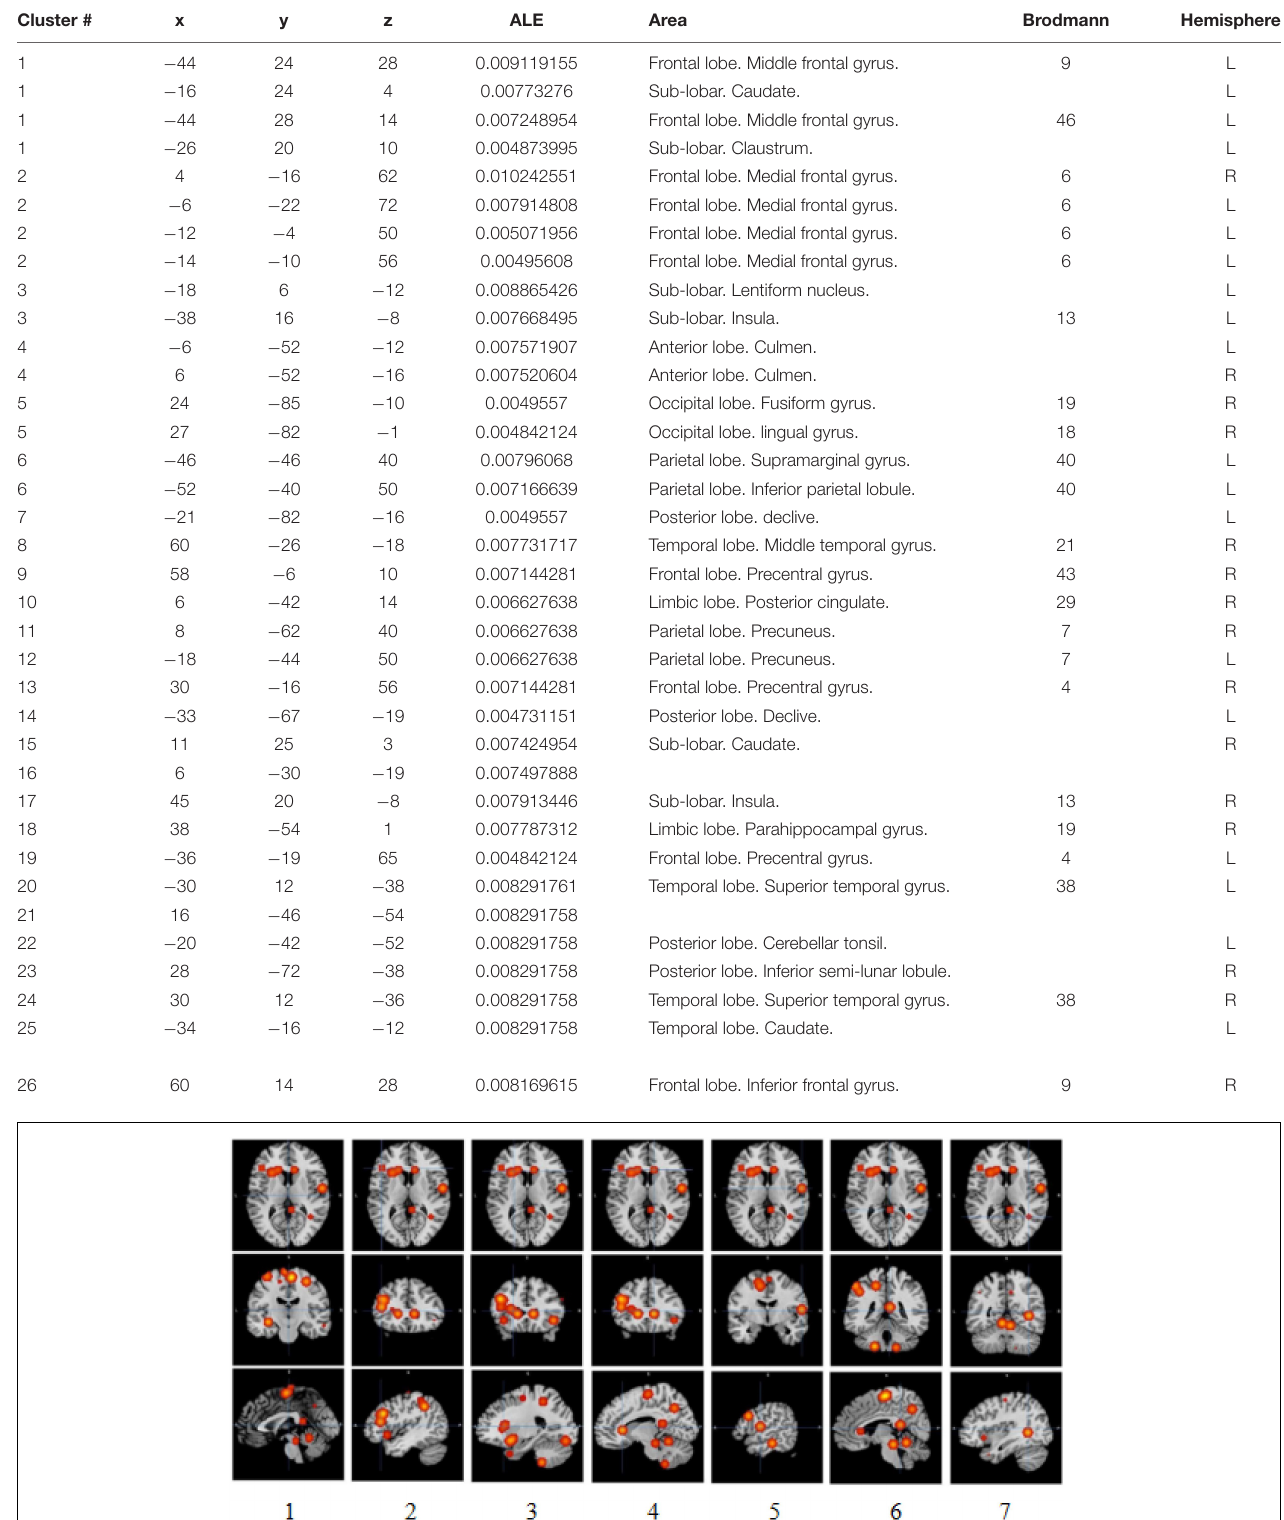
Frontiers in Human Neuroscience |